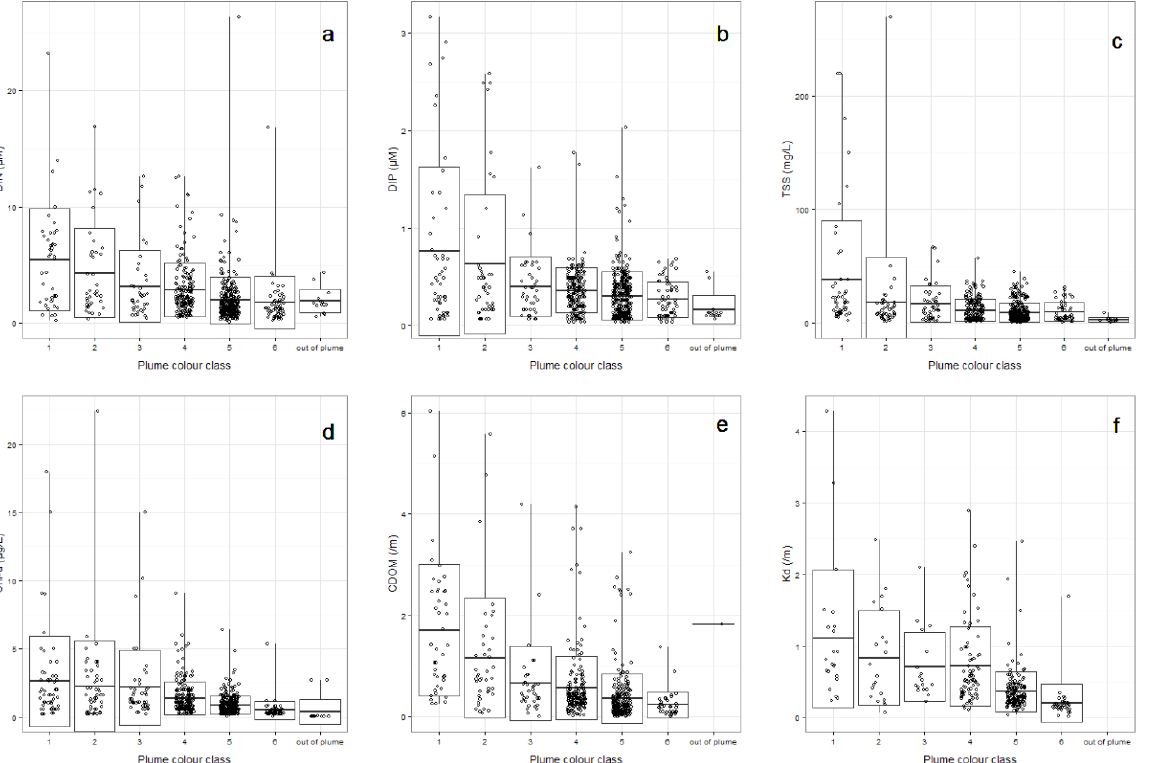
Figure 7. Box plot representing the data collected on two water quality measurements ( a ) Dissolved Inorganic Nitrogen, DIN (µM) and ( b ) Dissolved Inorganic Phosphorus, DIP (µM), the three main optical attenuating components of ( c ) TSS (mg/L), ( d ) CDOM (m −1 ), ( e ) chlorophyll-a (µg/L), and ( f ) light attenuation (Kd)PAR), m −1 ), are shown over each river plume colour class and “out of the plume” in wet season conditions. Boxplot presents the mean (dark black line), ±1 SD (rectangle) and maximum-minimum value (vertical lines). Nudge was applied to data on x-axis for better data visualization. Data is sourced from the Wet Season water quality monitoring program under the MMP between 2007 and